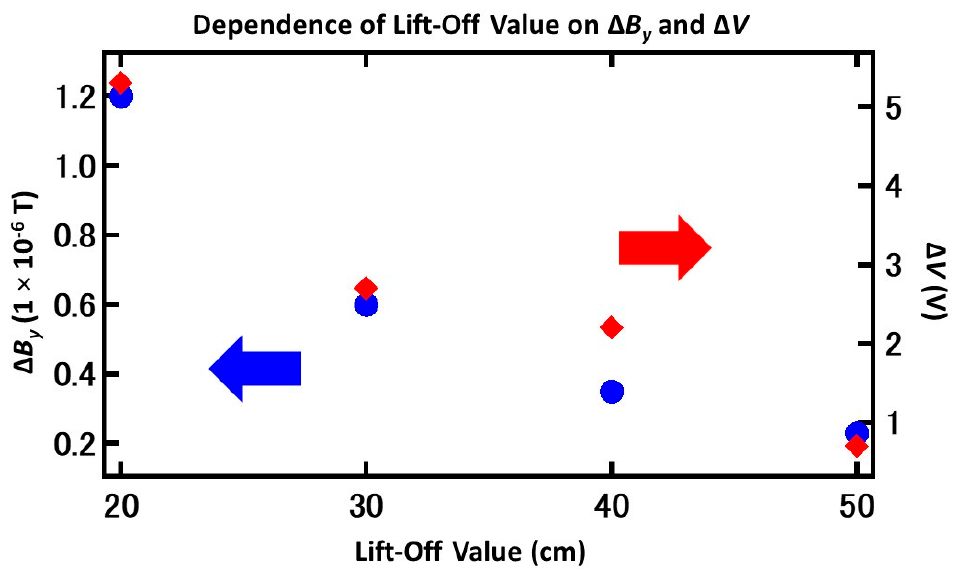
Figure 6. Results of the calculated Δ B y (difference between the highest peak and lowest peak from the theoretical calculation based on Equation (1)) and Δ V showed similar trends as lift-off increased.